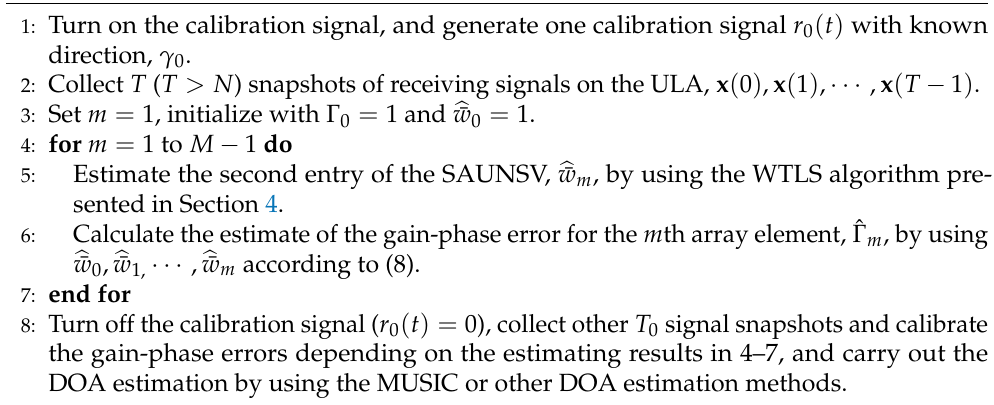
Algorithm 1 Proposed gain-phase error estimation